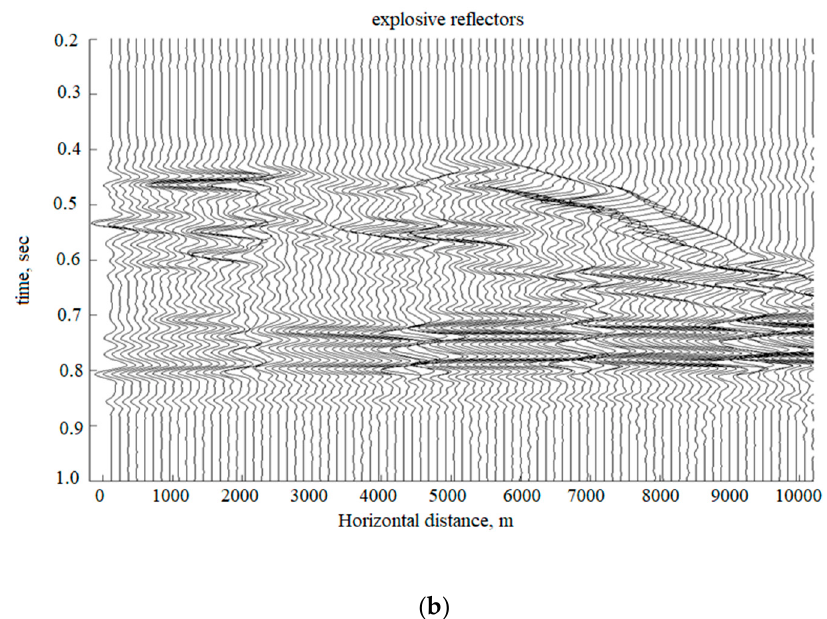
Figure 7. Comparison of zero offset 2D seismogram computed for the full model ( a ) and the one computed by exploding reflectors technique, presented in Section 4 ( b ).